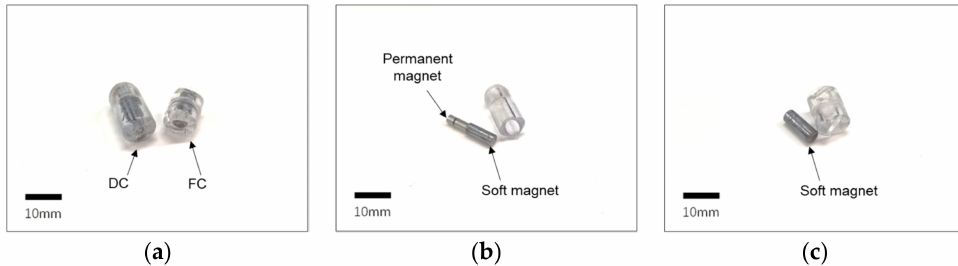
Figure 3. ( a ) Prototype of modular capsules. ( b ) The driving capsule (DC) showing the combination of the permanent magnet and soft magnet inside. ( c ) The functional capsule (FC) with the soft